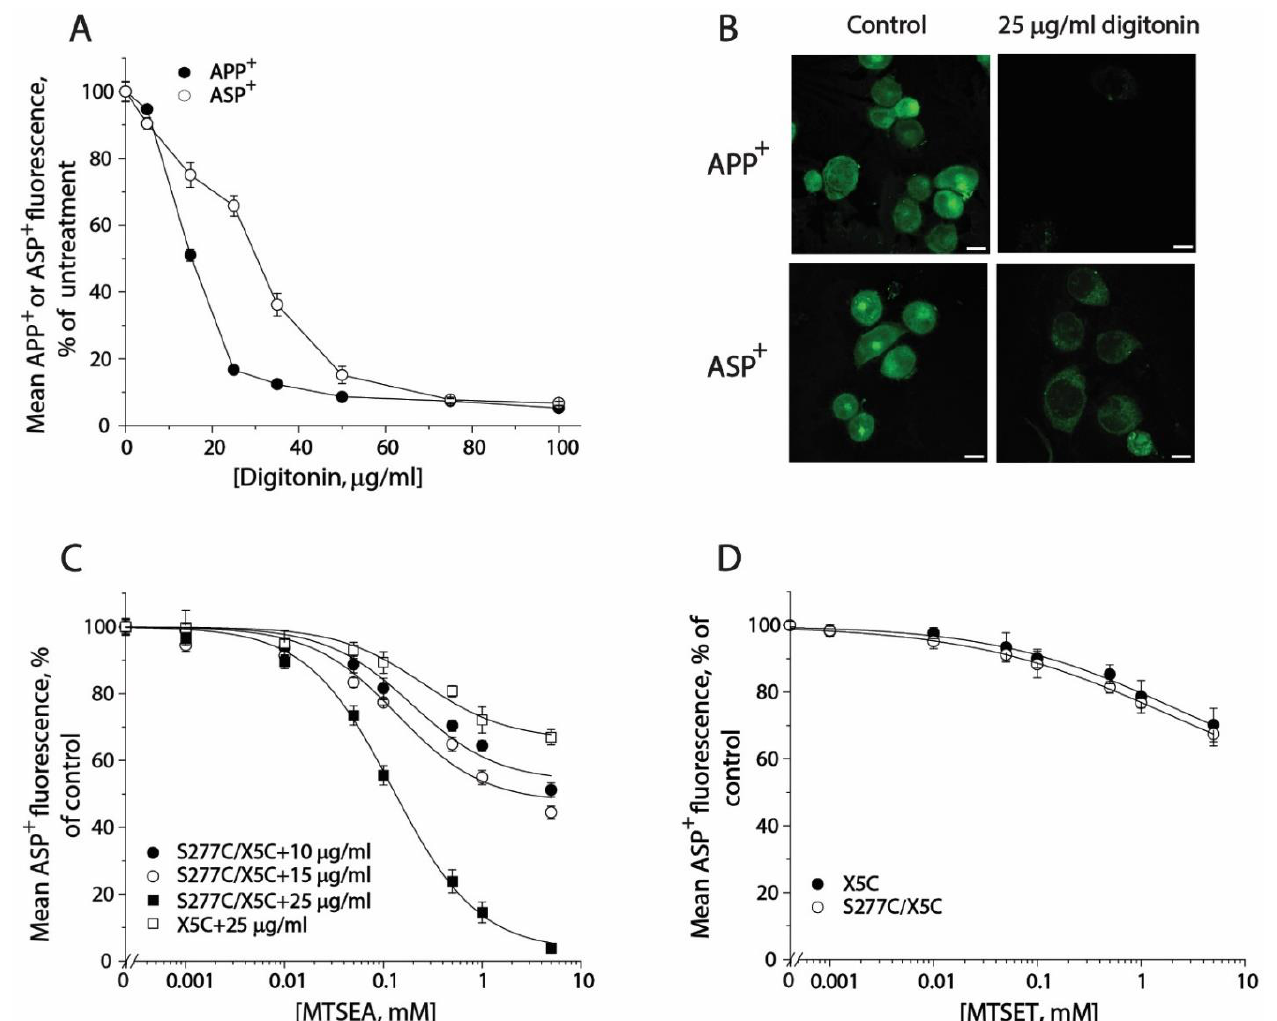
Figure 6. The effects of digitonin on APP + or ASP + accumulation and accessibility of S277C/X5C to MTS reagents. ( A ) The effects of digitonin on APP + and ASP + accumulation. The cells stably expressing WT-SERT were incubated with 2 µ M APP + or 10 µ M ASP + in the absence or presence of digitonin over a range of concentrations (10–100 µ g/mL) at 22 ◦ C for 5 min. After 3 × rapid washing with KRH buffer, APP + or ASP + accumulation was measured as described under “Materials and Methods”. The graph shows a representative experiment. The experiment was repeated twice with similar results. ( B ) Images of APP + or ASP + fluorescence (green) accumulated in the presence or absence of 25 µ g/mL digitonin (scale bar: 10 µ m). These representative images were parallelly acquired from one experiment. The experiment was repeated twice with similar results. ( C ) MTSEA concentration-dependent inhibition of ASP + binding of S277C/X5C. The cells stably expressing S277C/X5C were incubated with MTSEA over a range of concentrations (1 µ M to 5 mM) in the absence or presence of 10, 15, or 25 µ g/mL digitonin at 22 ◦ C for 5 min. After 3 × washing, ASP + binding to the cell membrane was measured as described under “Materials and Methods”. The effect of MTSEA on ASP + binding of the background construct, X5C, in the presence of 25 µ g/mL digitonin was also parallelly examined. The graph shows a representative experiment. Two more experiments were performed with similar results. ( D ) The effects of MTSET on ASP + binding of S277C/X5C and X5C. The cells stably expressing S277C/X5C or X5C were incubated with 10 μM ASP + with MTSET over a range of concentrations (1 μM to 5 mM) in the absence or presence of 25 μg /mL digitonin for 5 min. After 3 × rapid washing, ASP + binding was measured as described under “Materials and Methods”. The graph shows a representative experiment. Two more experiments were performed with similar